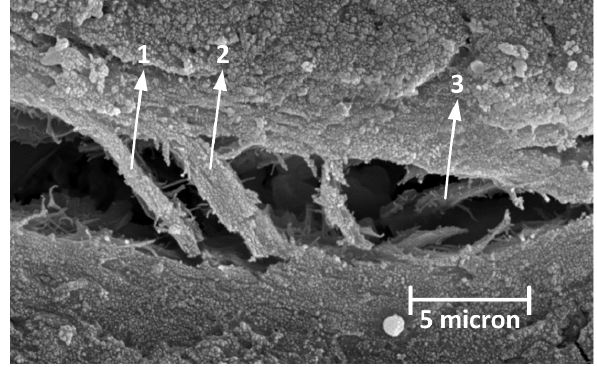
Figure 5: Two interstitial lamellae separated from each other by a crack. The white arrow 1 indicates the phenomenon “fibers pull- out”, the white arrow 2 indicates the phenomenon “fibers bridging”, and the white arrow 3 indicates the phenomenon “fibers